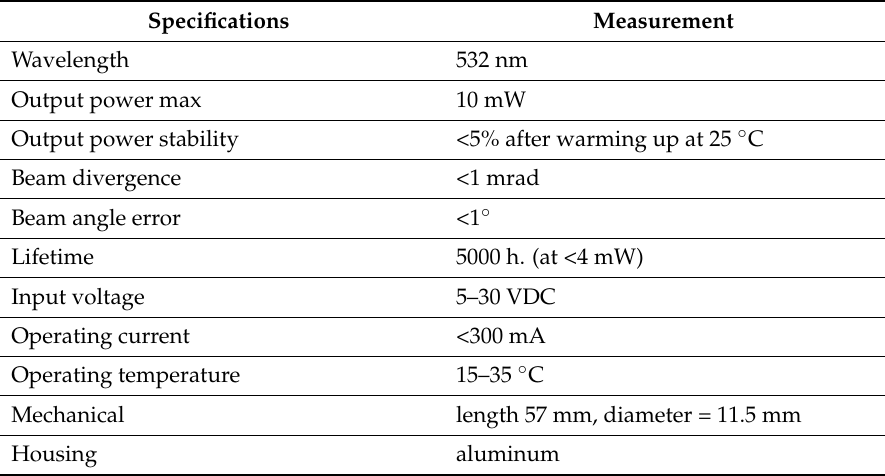
Table 2. FLEXPOINT 532 nm green laser module specifications.